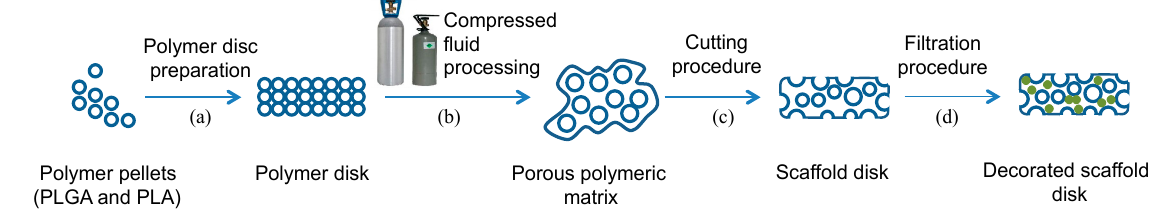
Figure 2. Scheme of the experimental procedure for preparing 3D porous scaffolds. (a) First, polymeric disks were prepared from PLA or PLGA polymer pellets. (b) The disks were then transformed into porous scaffolds using compressed fluid processing in a high-pressure plant. (c) The non-porous skin layer was cut out, obtaining a porous scaffold disk. (d) The disk was subsequently loaded with bioactive pNPs by a filtration procedure.